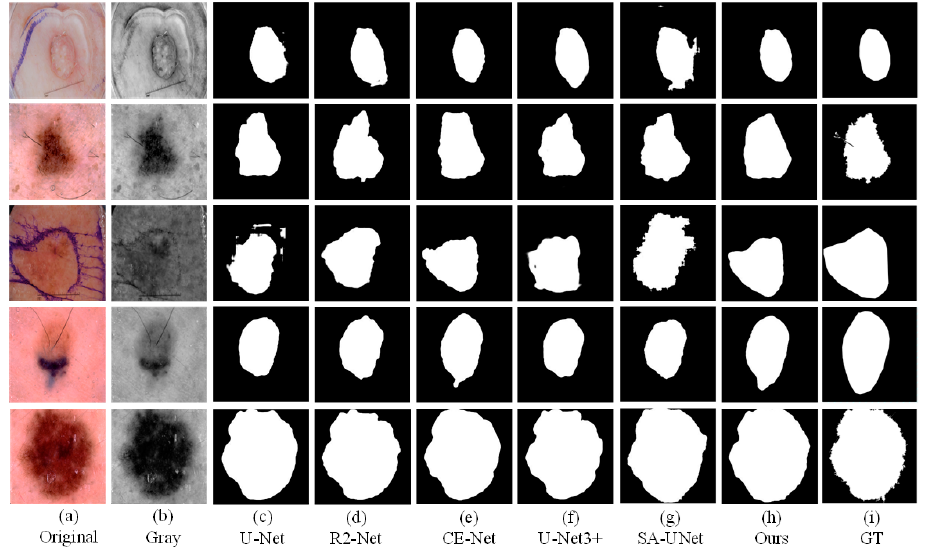
Figure 9. The visual segmentation comparison chart of each comparison network on ISIC2017. ( a , b ) represents original and gray-scale images of input, ( i ) represents GT maps. ( c – g ) represent the segmentation results of comparison networks, respectively. ( h ) represents the segmentation result of our proposed method, from which it can be seen that the segmentation result of our proposed method is the closest to the GT maps.